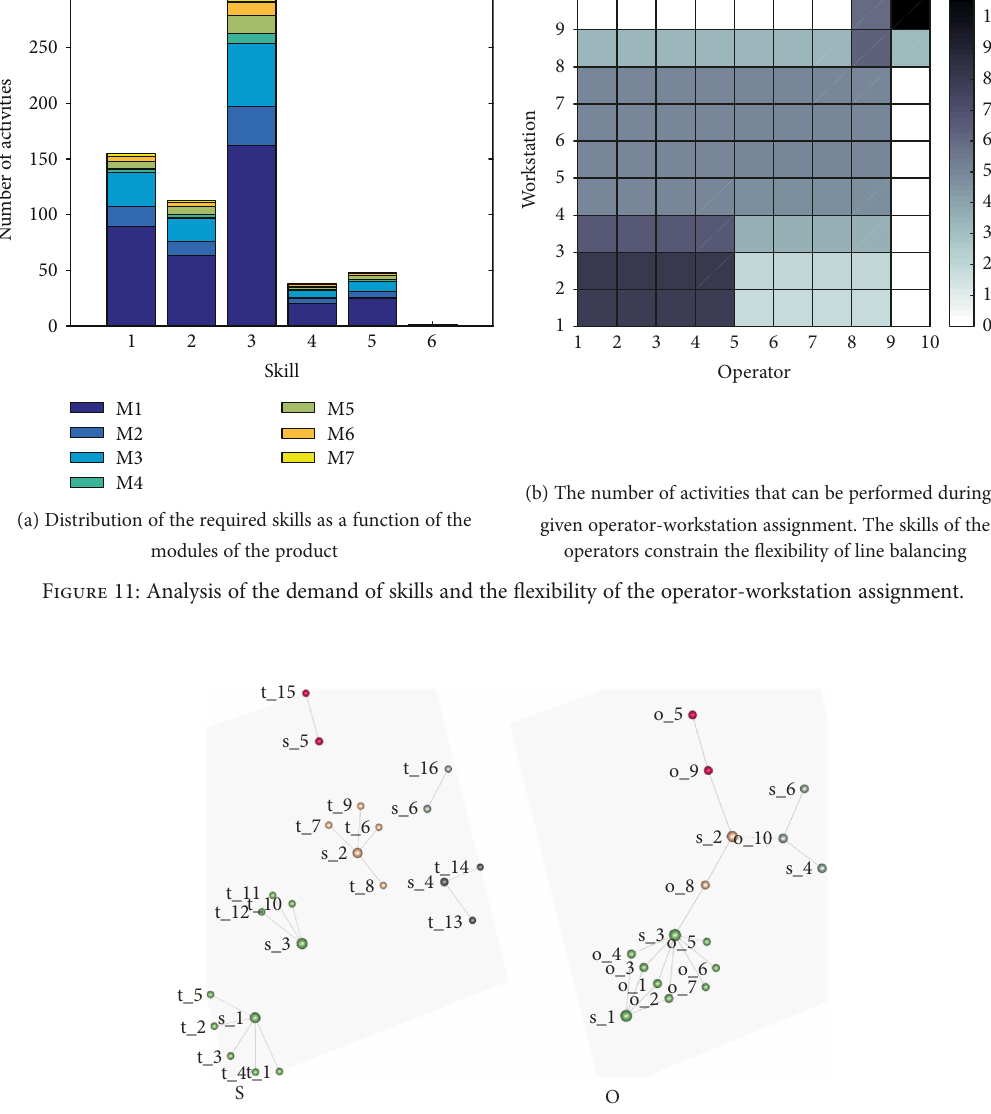
Figure 12: Skill (S) and operator (O) layers de fi ne the network that can be used to determine elements of critical knowledge which is useful in terms of the design of training programs for the